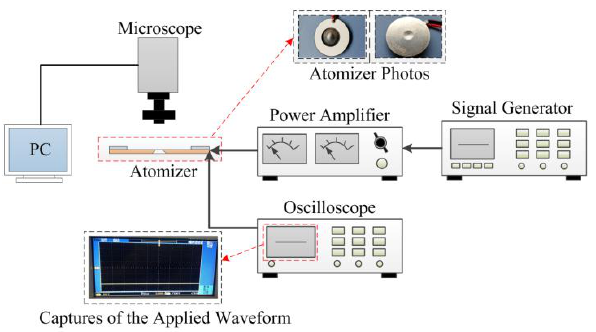
Figure 4. Method used to measure the micro-aperture and the captures of the applied waveform.